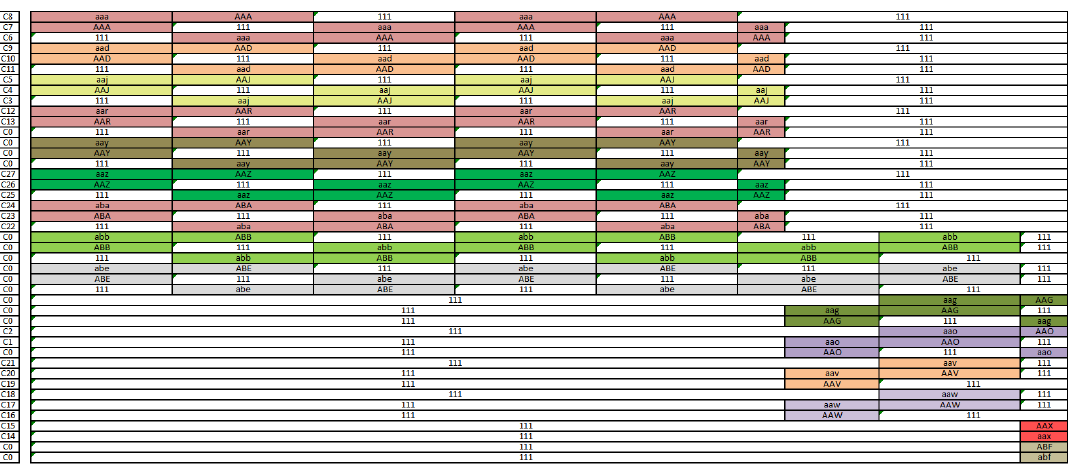
Figure 13. An initial solution in instance